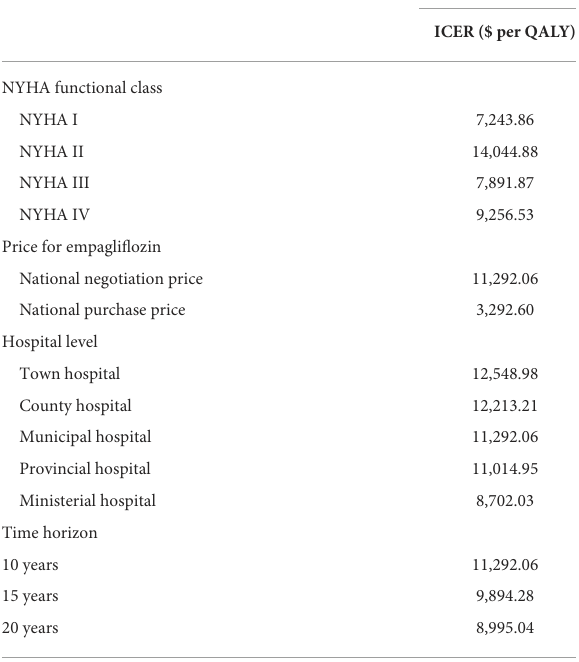
TABLE 4 The result of scenario analyses presented as